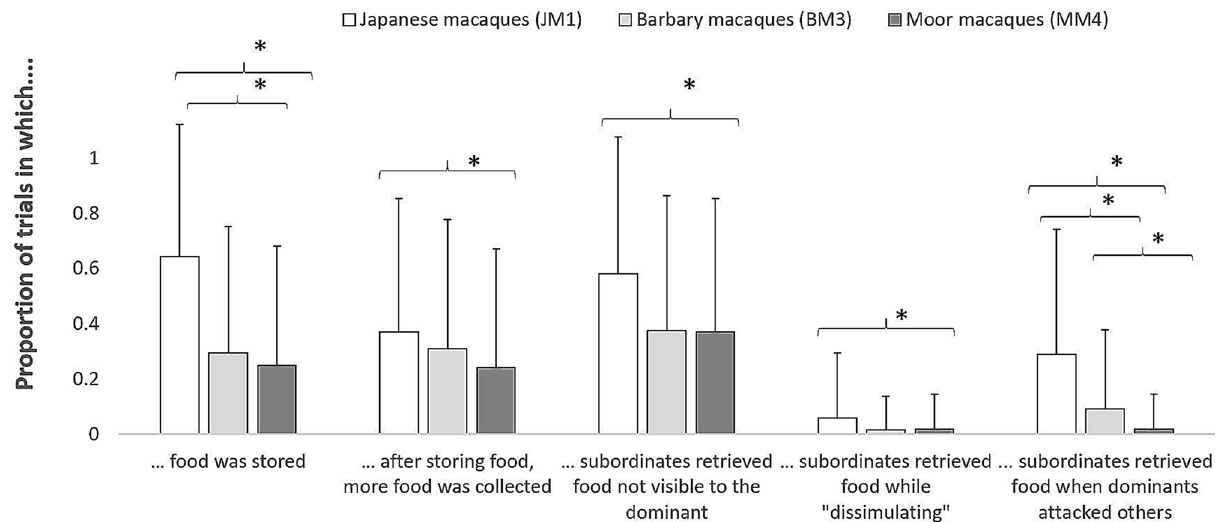
Figure 2. For each species separately, mean (+ SD) proportion of trials in which macaques stored food, in which they collected more food after storing one piece, in which they retrieved food which was not visible to the most dominant, while “dissimulating”, or when dominants were involved in aggressive interactions with other individuals. Significant differences between species are marked with an